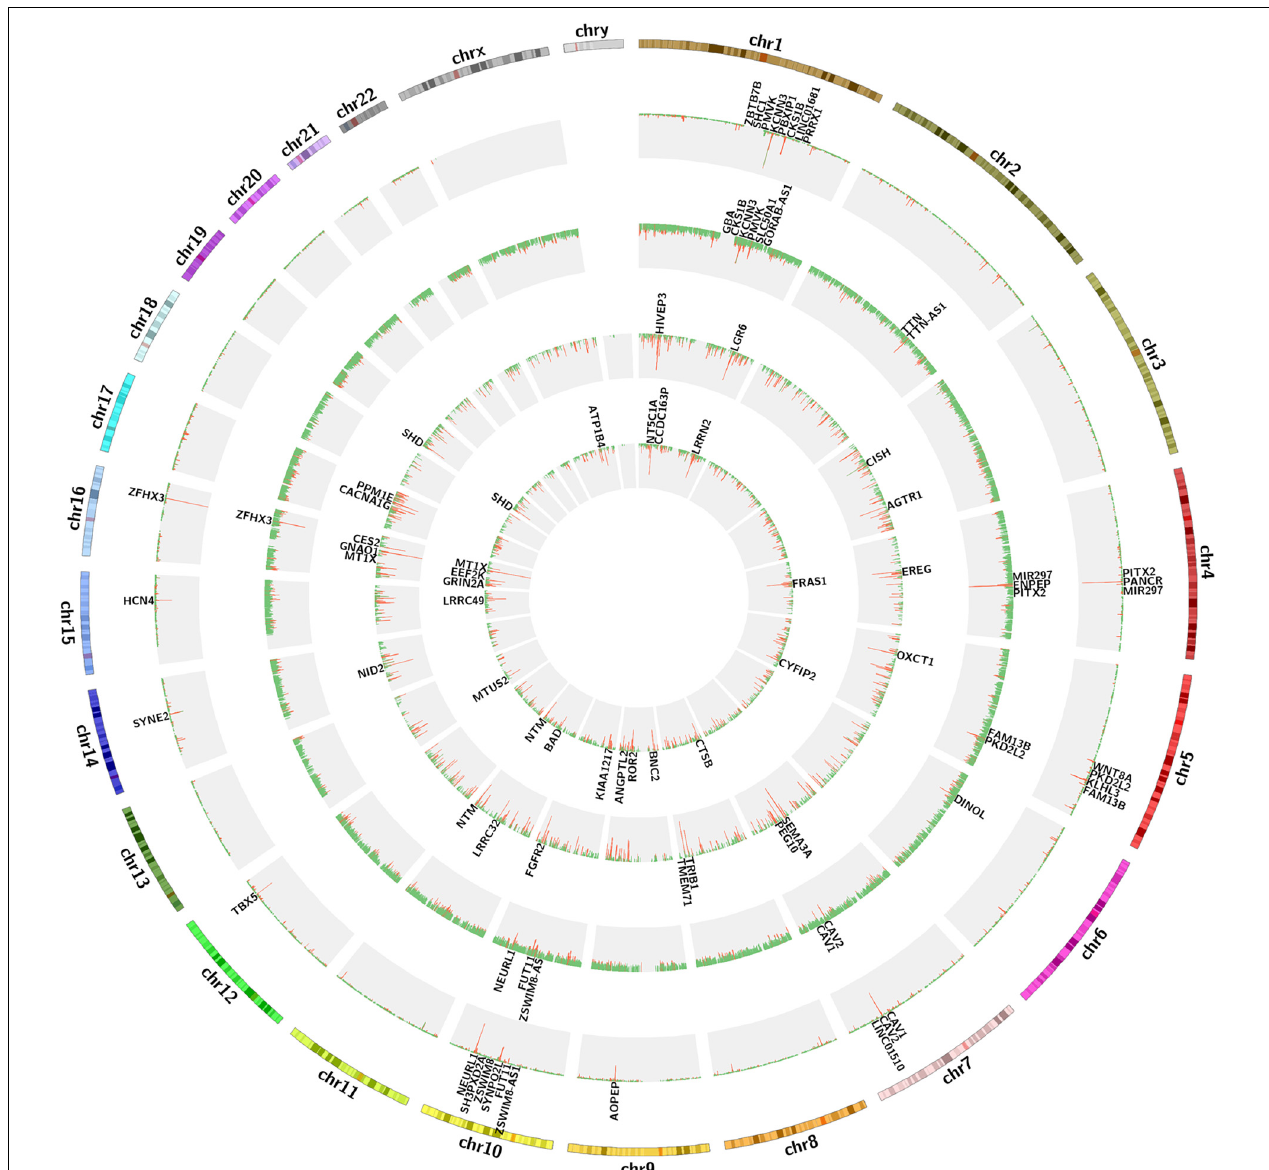
FIGURE 1 | The circos diagram for GWAS and expression data sets. Two outermost tracks represent the chromosome text and banding positions. From the outside to the inside, the first and second histogram tracks represent the GWAS discovery and test sets, respectively. The red abundance value along the vertical axis represents the genes with adj p < 0.05, the first 20 of which are displayed in the first and second text tracks, and the green represents the genes with adj p > 0.05. The third and four histogram tracks represent the GS values of the expression sets of LAA and RAA, respectively. The red abundance value along the vertical axis represents the genes with GS > 2, the first 20 of which are displayed in the third and four text tracks, and the green represents the genes with GS < 2. GS, gene significance; LAA, left atrial appendage; RAA, right atrial